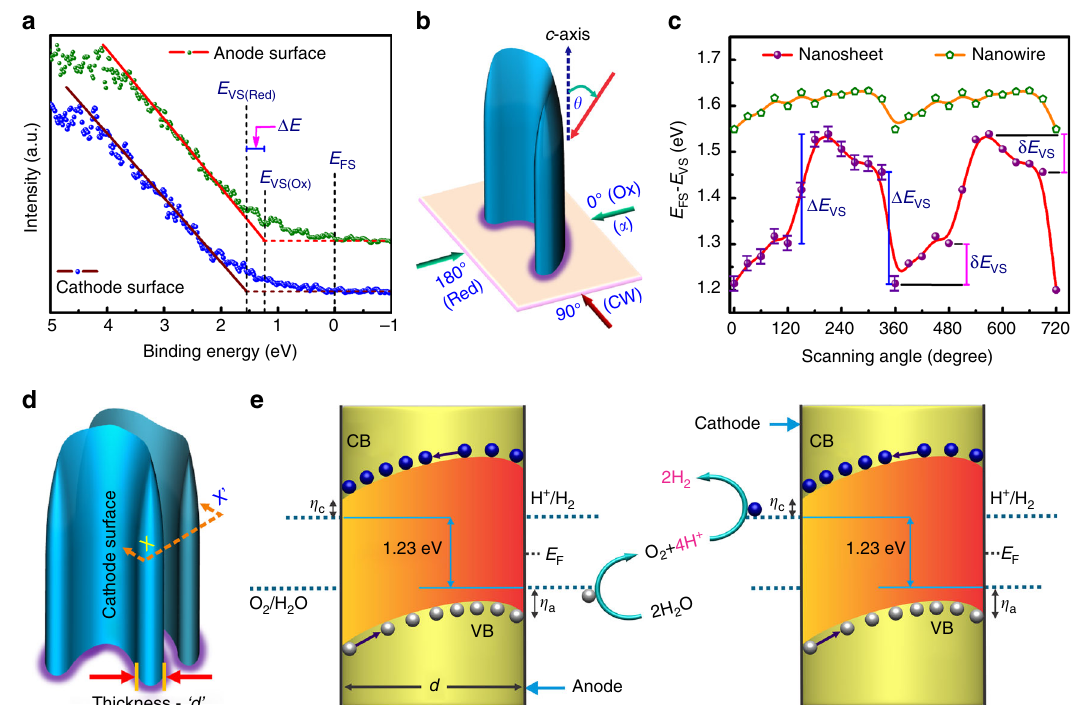
Fig. 3 Surface charge properties of In 0.22 Ga 0.78 N:Mg photochemical diode. a ARXPS valence spectrum for cathode and anode surface of p-InGaN photochemical diode nanosheets, depicting the offset in surface valence band maximum ( E VS ) relative to surface Fermi-level ( E FS ). b Schematic illustration of probing photochemical diode surfaces for valence spectra using ARXPS. Angles on the imaginary plane normal to c -axis (parallel to the substrate) are the radial scanning angles ( α , clockwise), and “ θ ’ “ denotes the angle of X-ray excitation relative to c-axis (See Methods). c E FS − E VS for Mg-doped In 0.22 Ga 0.78 N nanosheets and nanowire arrays, derived from ARXPS valence spectrum as a function of scanning angle. Periodic fl uctuation is clearly observed for E FS position on the photochemical diode nanosheets relative to E VS . An error bar of ~±0.03 eV corresponds to uncertainties involved in measuring E VS and C 1s peak. d , 3D depiction of photochemical diode nanosheets with an arbitrary radial thickness ‘ d ’ . Inner surface of the curved nanosheet is denoted as the cathode surface as per Fig. 2. e Neutral pH overall water splitting on the surfaces of photochemical diode nanostructures, presented schematically as a top view at the plane (X-X ′ ) of cross-section in Fig. 3d. η a and η c represents the anodic and cathodic over-potentials for water oxidation and proton reduction reaction, respectively. With the directional (opposite) migration of electrons and holes, redox reactions can be coupled between parallel (cathode and anode) surfaces of vertically aligned adjacent photochemical diode